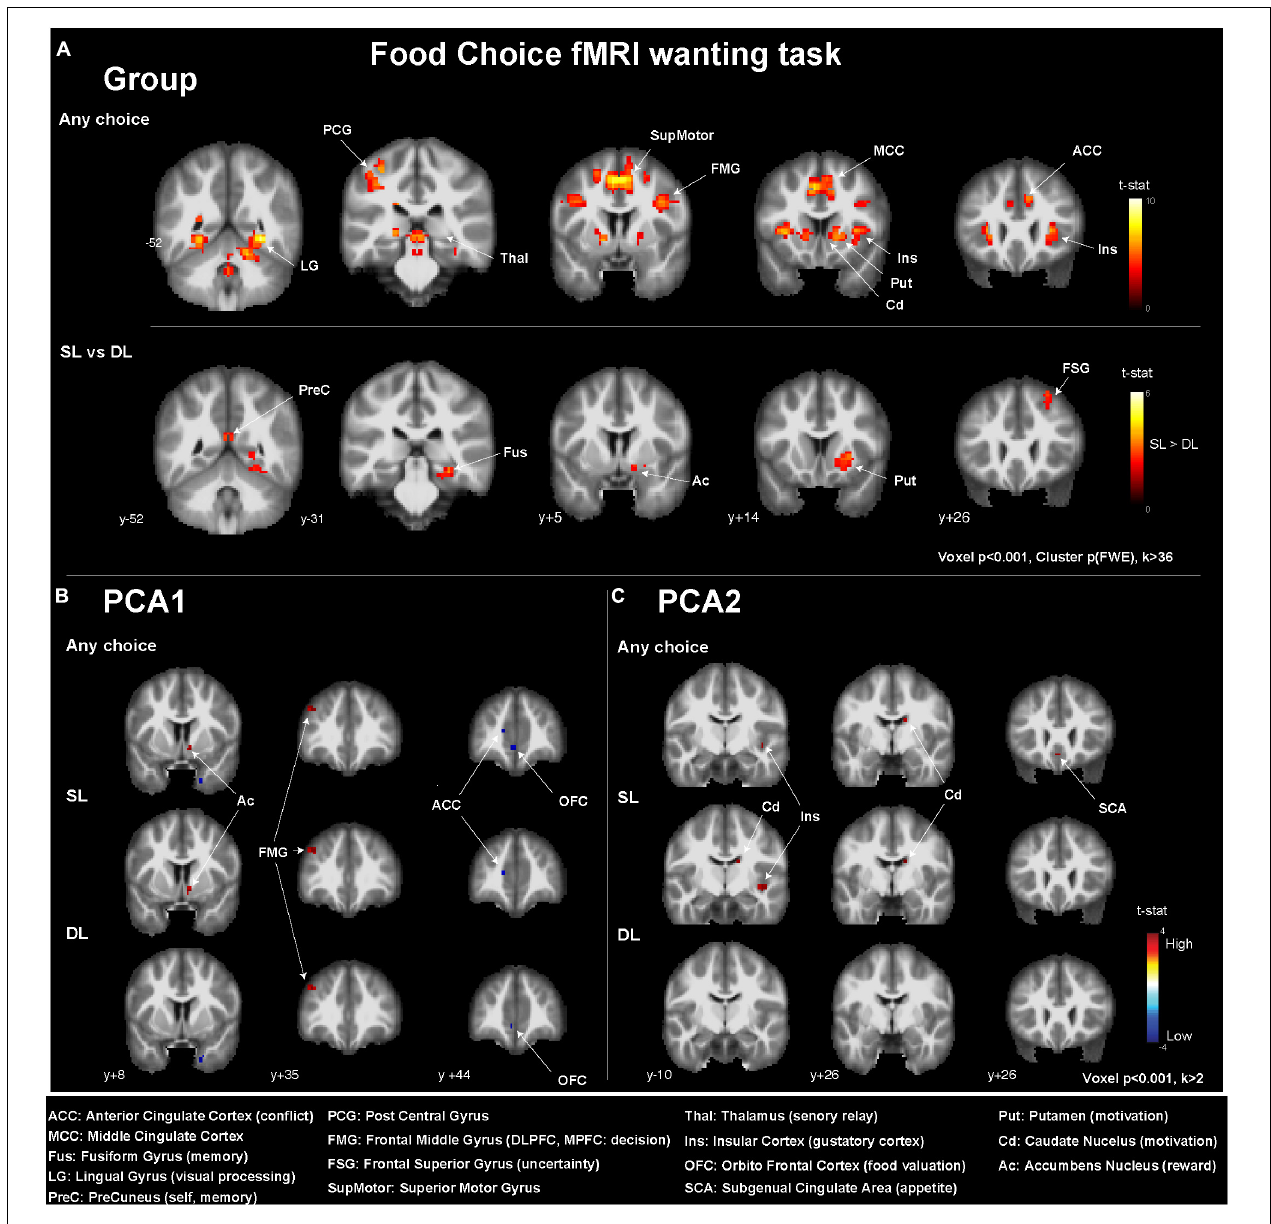
FIGURE 3 | Brain activations detected in the fMRI two-choice task viewed in coronal slices (A) for all participants ( n = 50), (B) depending on the PCA1 values, and (C) depending on PCA2 values. MNI y -coordinates are indicated for each coronal slice. ACC, anterior cingulate cortex; MCC, middle cingulate cortex; Fus, fusiform gyrus; LG, lingual gyrus; PreC, precuneus; PCG, posterior central gyrus; FMG, frontal middle gyrus; FSG, frontal superior gyrus; SupMotor, superior motor gyrus; Thal, thalamus; Ins, insular cortex; OFC, orbitofrontal cortex; SCA, subgenual cingulate area; Put, putamen; Cd, caudate nucleus; Ac, accumbens